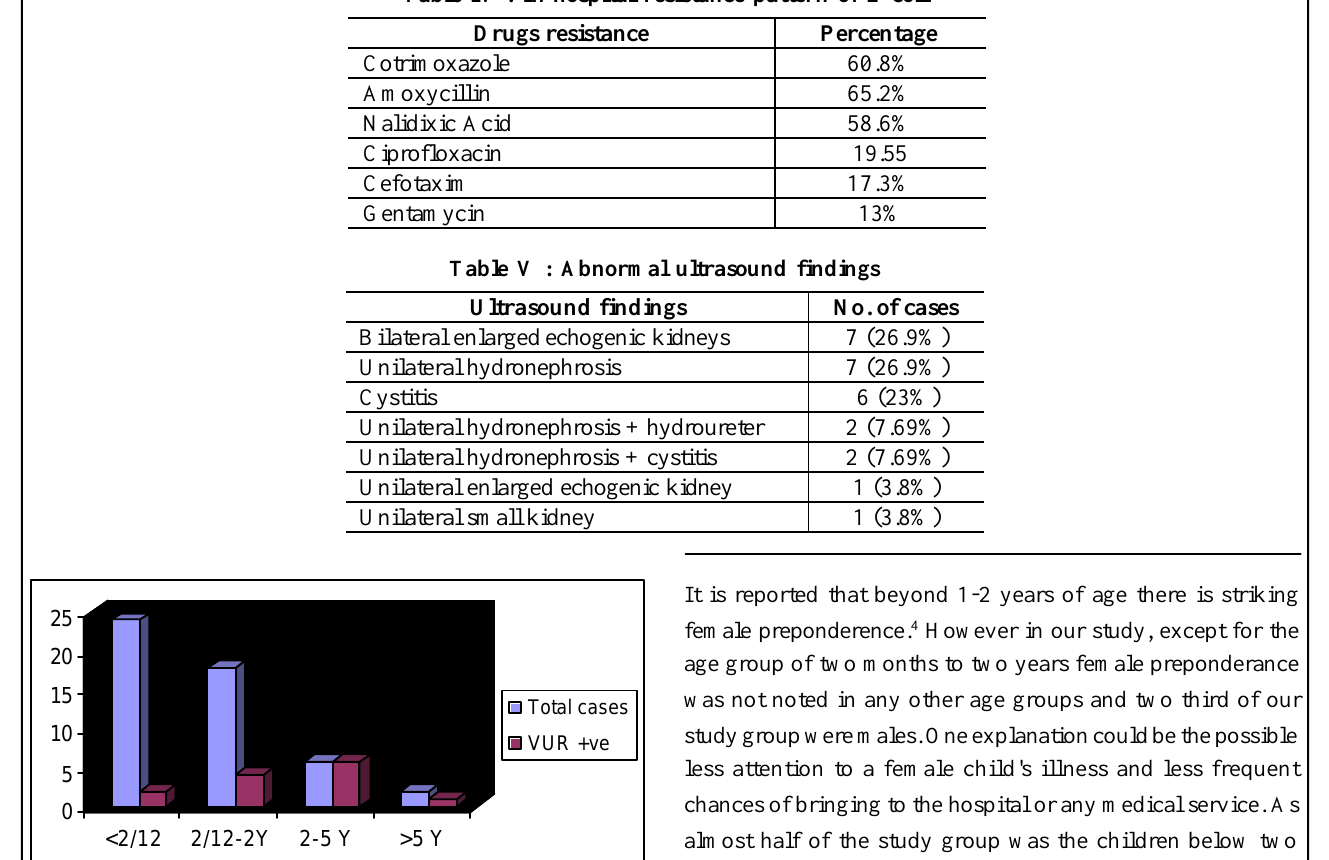
Fig. 4 : VUR in relation to age group.